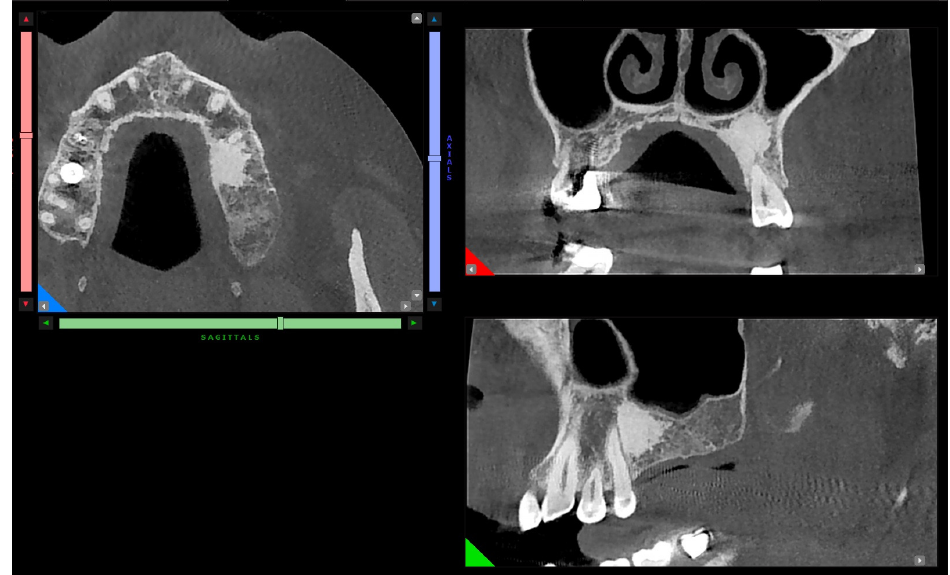
Figure 3. Axial, sagittal, and paracoronal view of the hyperdense finding in CBCT examination.